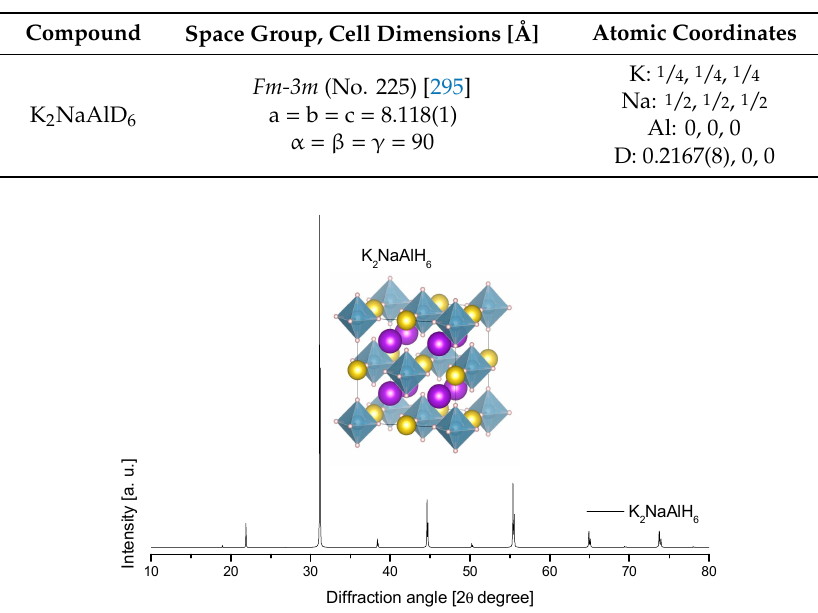
Figure 26. Crystal structure of Na-K mixed alanate and its calculated diffraction pattern ( λ = Cu k α 1 ).